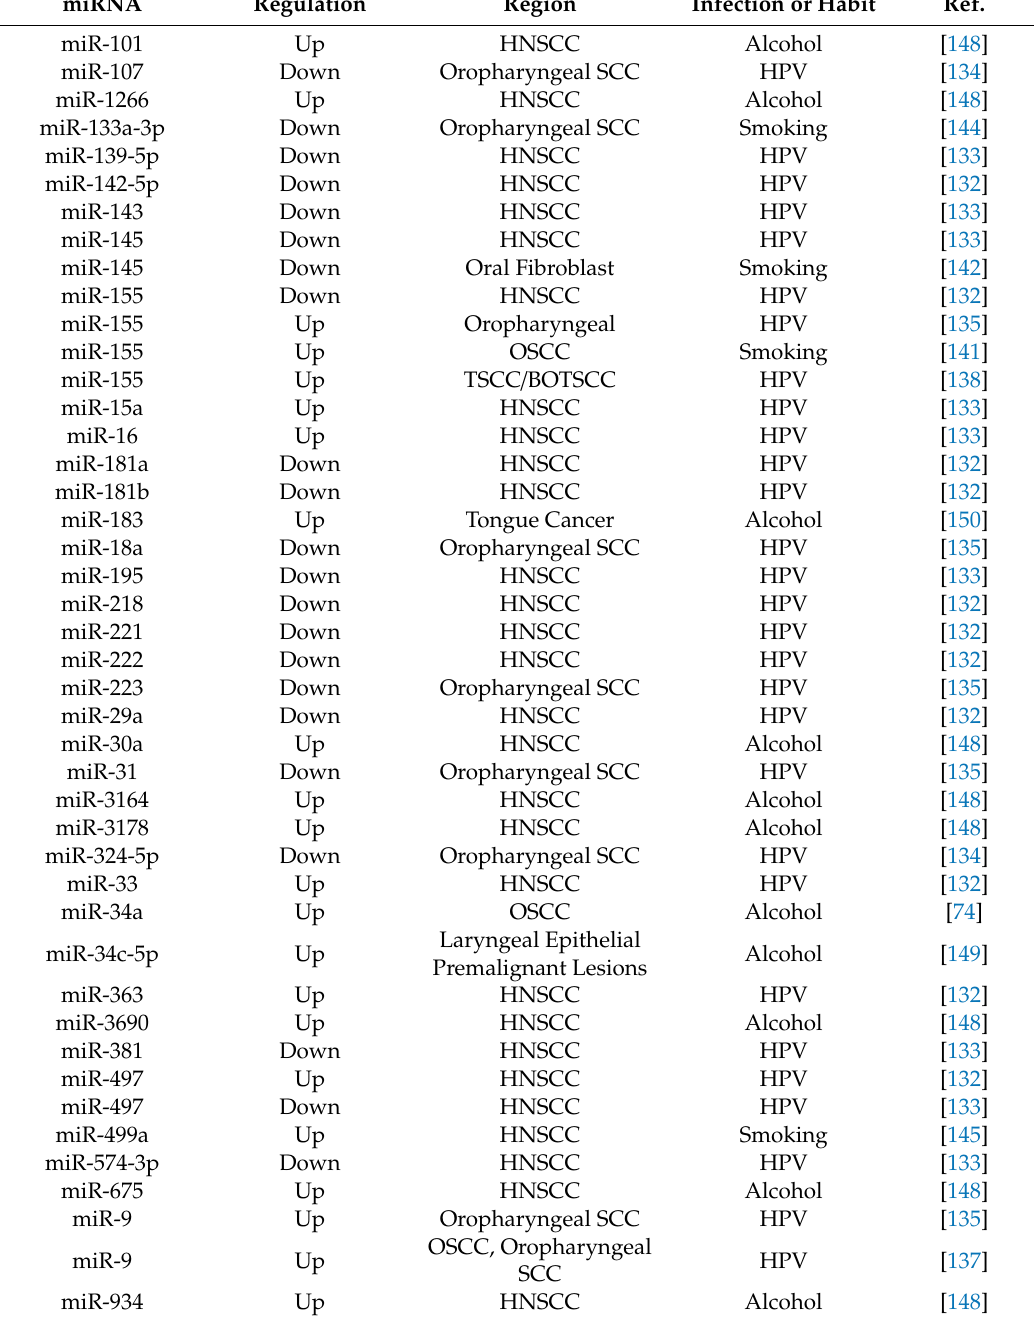
Table 5. HPV, smoking, or alcohol related miRNA